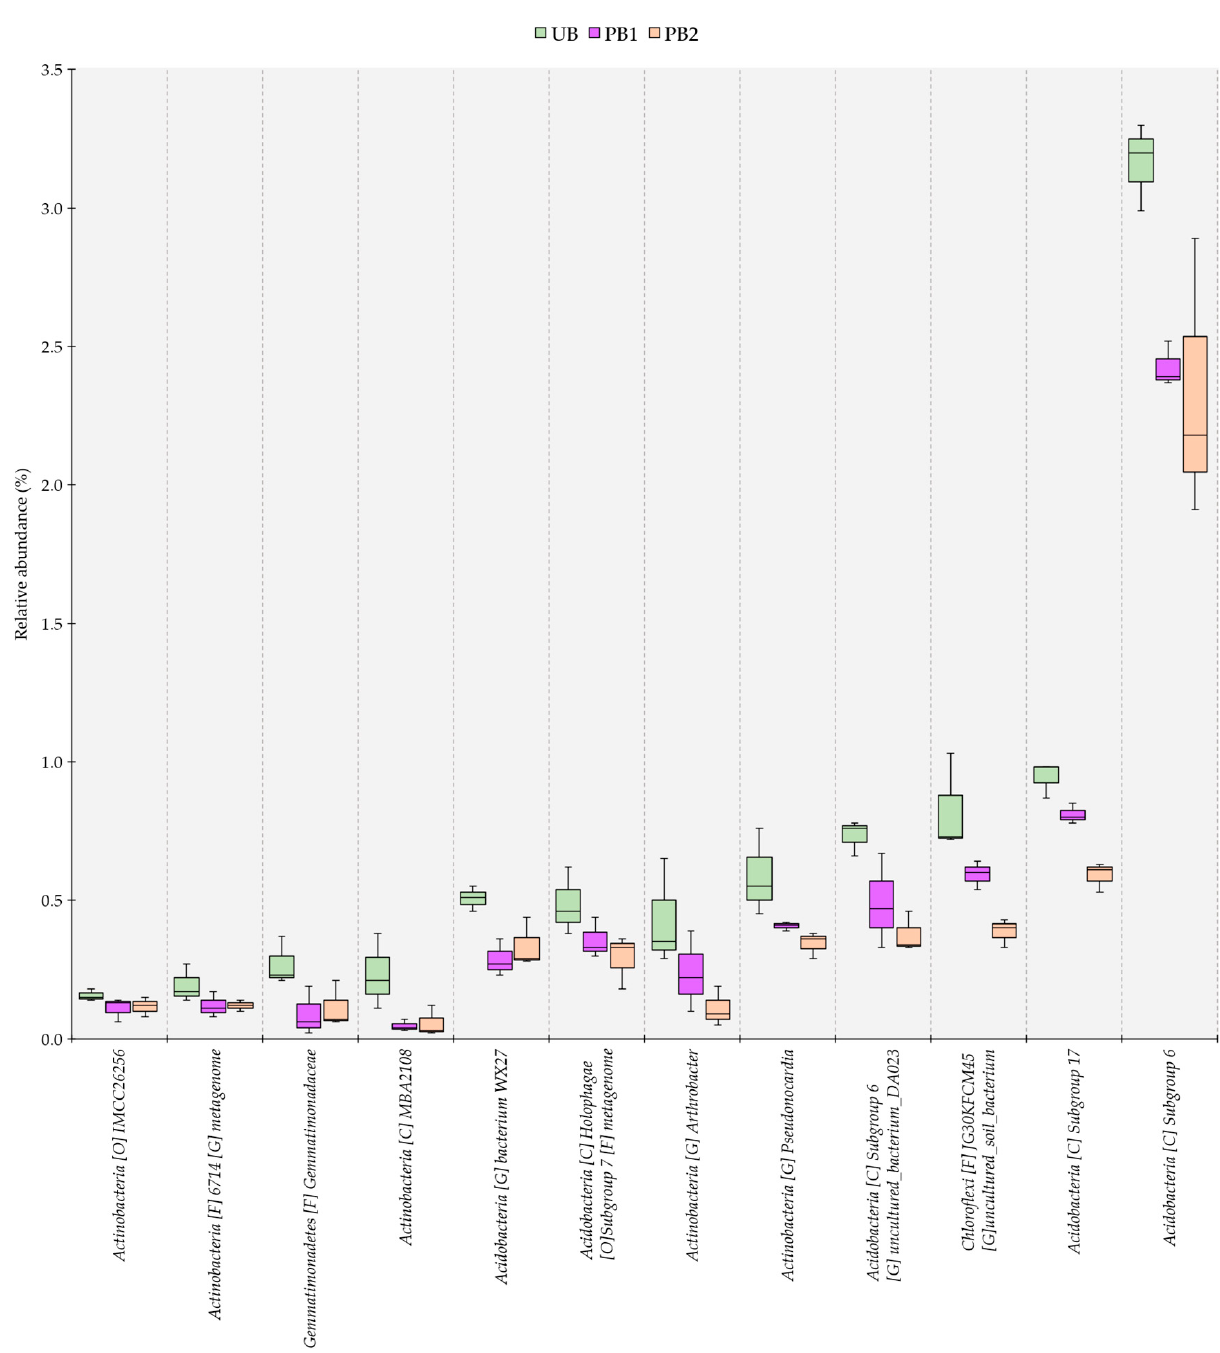
Figure 5. Bacterial groups decreasing in relative abundance (%) after prescribed burn treatment regardless of time since burn application compared to UB. UB: control; PB1: soils treated with prescribed burning seven months before sample collection; PB2: soils treated with prescribed burning immediately prior to sample collection. Boxes include 50% of the data between the first and third quartiles (interquartile range) and the central line, the median. The whiskers include those values that deviate from the first and third quartiles up to a maximum distance of 1.5 times the interquartile range. Capital letters in square brackets indicate the lowest taxonomic level of classification: [O]: order, [C]: class, [F]: family, [G]